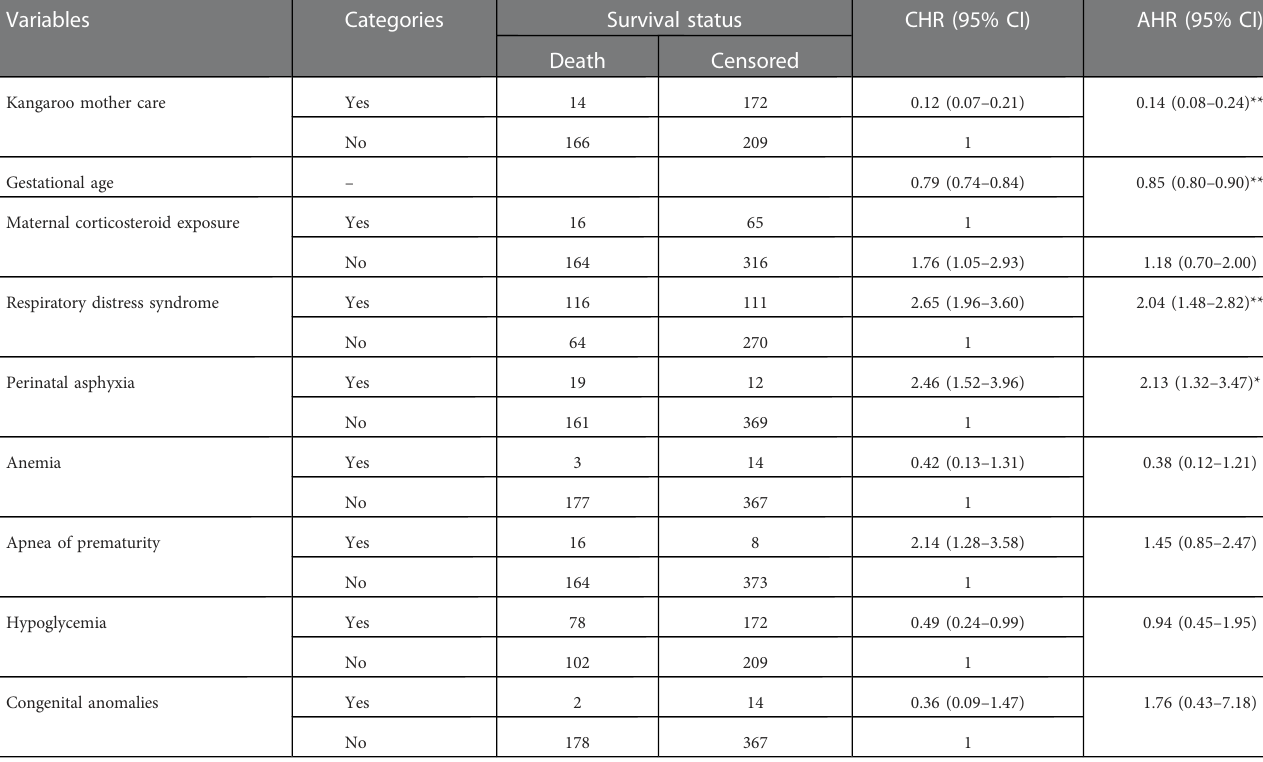
TABLE 3 Bivariable and multivariate Cox proportional hazard regression output for predictors to the time to death of preterm neonates in Northern Ethiopia, between February 1, 2017, and January 30, 2022 ( n =561). Variables